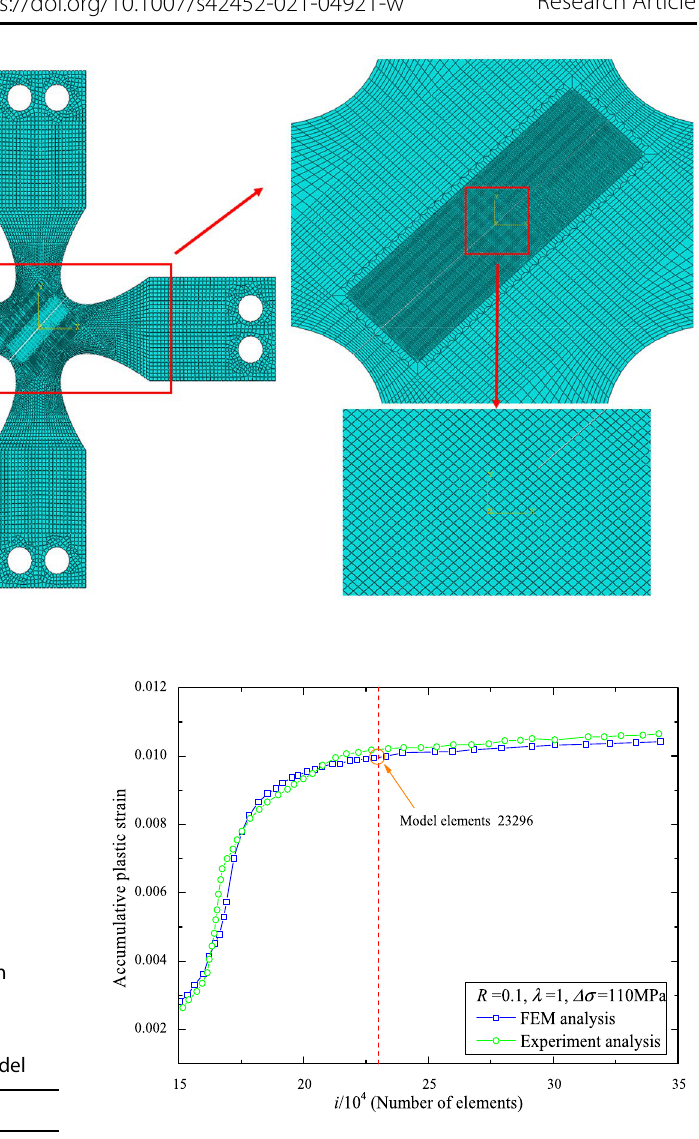
Fig. 17 Convergence judgment of accumulative plastic strain at crack